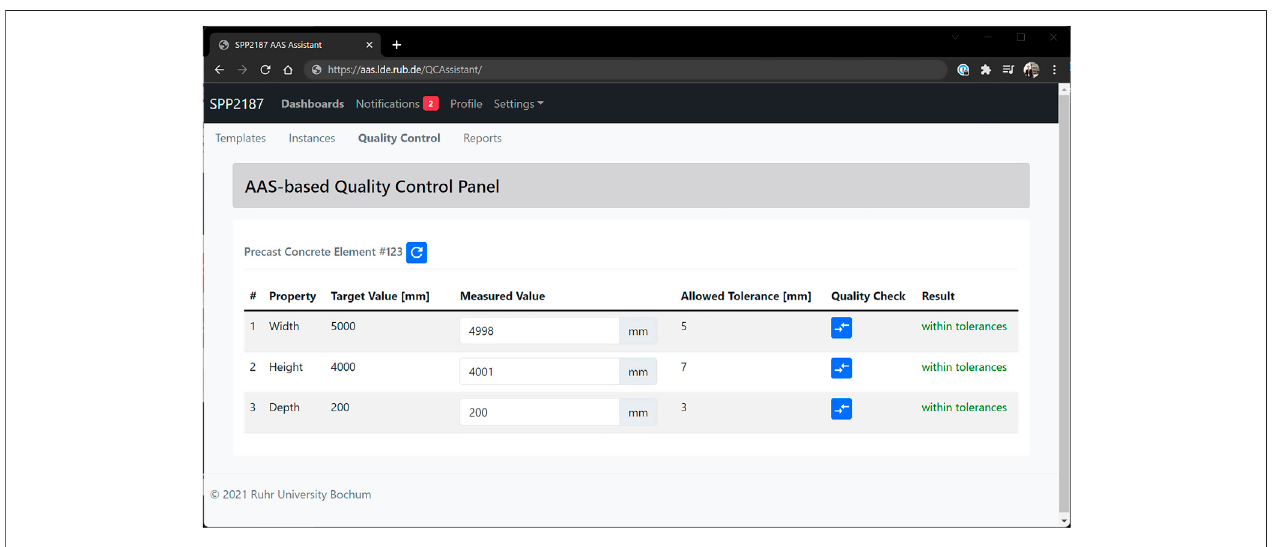
FIGURE 12 | Web-based